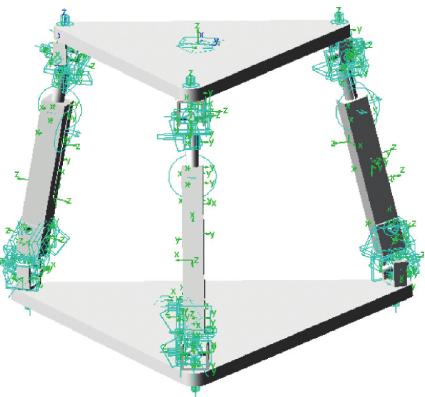
Figure 14: The force of branch 1.